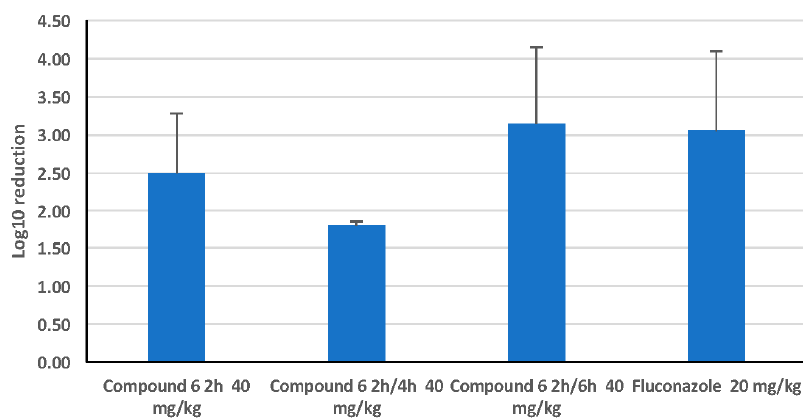
Figure 6. 24-hour treatment of C. albicans disseminated candidiasis with Compound 6 in single and split doses compared with fluconazole. Mean log 10 reduction of colony forming units (cfu) of Candida albicans following SC treatment with Compound 6 at 50% of the maximum tolerated dose (MTD), 40 mg/kg, 2 h following IV infection with 3.5 × 10 4 cfu/mouse for 24 h. Split doses of 20 mg/kg were given twice at 2 and 4 h and 2 and 6 h after infection. Groups were compared to a control group dosed with kleptose and infected with 3 × 10 4 cfu C. albicans per mouse. For comparison, female Swiss CD.1 mice were gavaged 2 h after infection with 20 mg/kg fluconazole for 24 h.